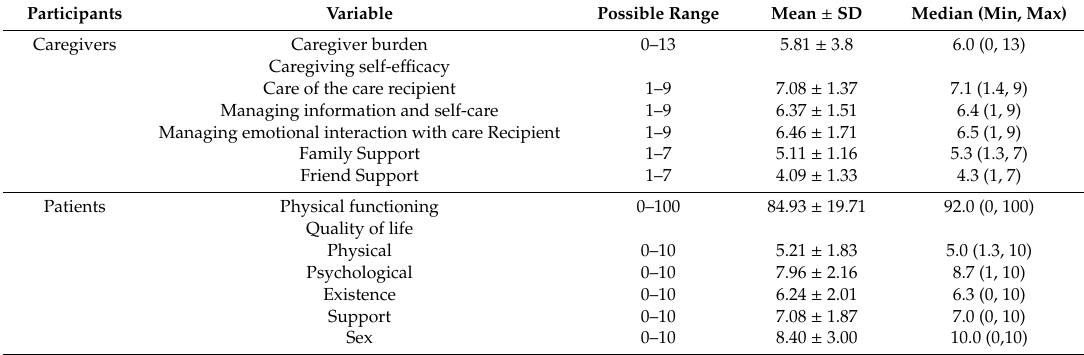
Table 2. Descriptive statistics of outcome measures in patients and their caregivers ( n =